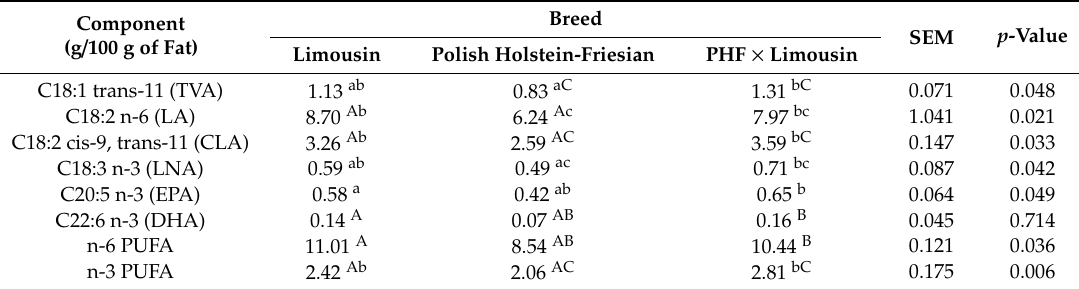
Table 5. The influence of breed on MUFA and PUFA levels in muscle tissue. Component (g / 100 g of